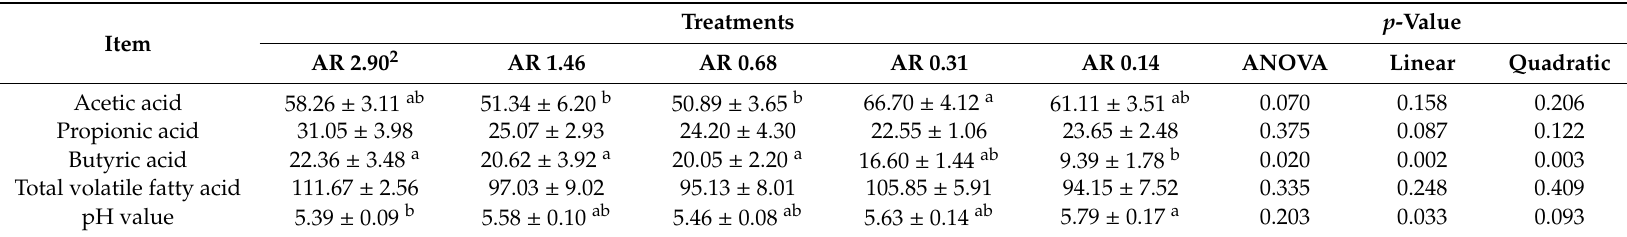
Table 8. E ff ects of dietary starch structure on the intestinal microbial metabolites ( µ mol / g of wet digesta) and pH value in the cecum in weaned piglets (mean values with their standard errors) 1 .